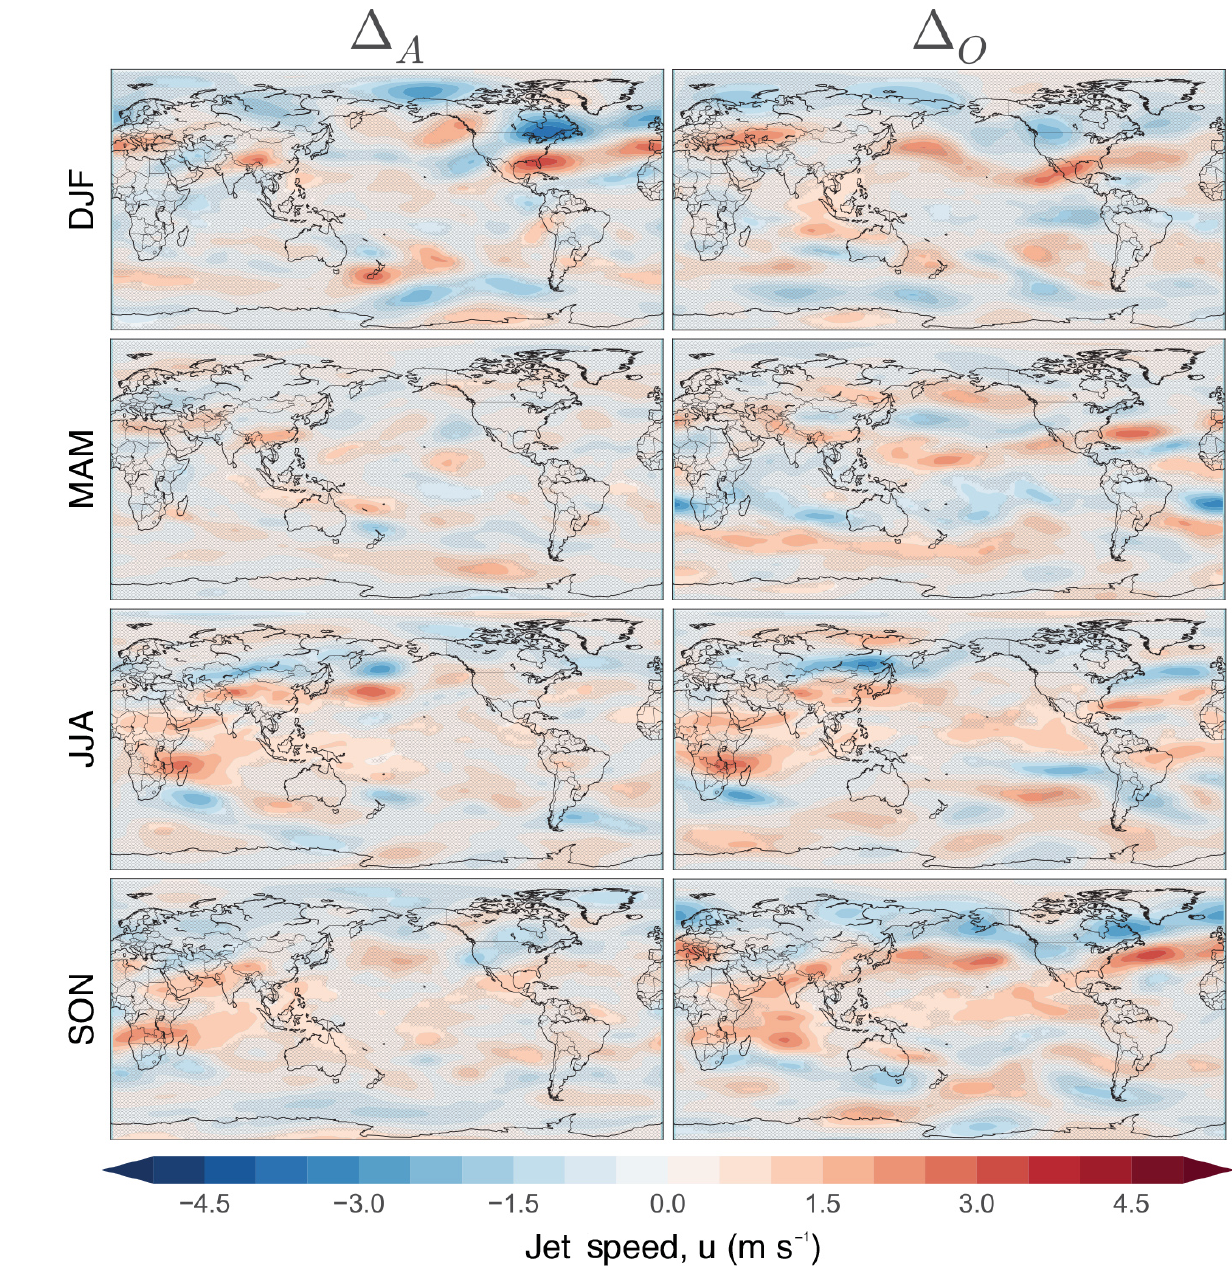
Figure 6. Same as Fig. 3 but for jet stream meridional velocity differences (ms − 1